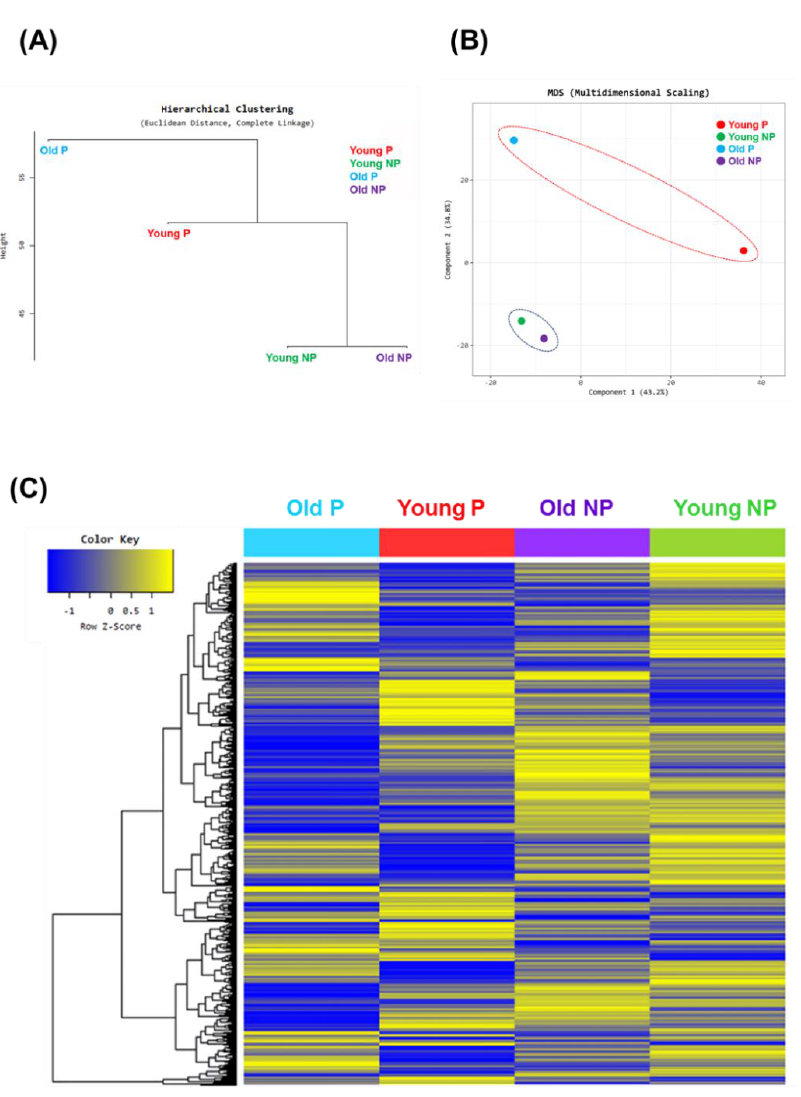
Figure 1. Graphs of Euclidean distance, multidimensional scaling analysis, and hierarchical clustering heatmap analysis. Hierarchical clustering by ( A ) Euclidean distance and ( B ) multidimensional scaling (MDS), comparing age and pregnancy: young pregnancy (Young P, red), young non-pregnancy (Young NP, green), old pregnancy (Old P, blue), old non-pregnancy (Old NP, purple). ( C ) Graph of hierarchical clustering heatmap indicating differentially up- and downregulated genes based on age and pregnancy outcome. Color intensity indicates gene expression, normalized using log2(FPKM) values. Yellow and blue indicate up- and downregulation, respectively.